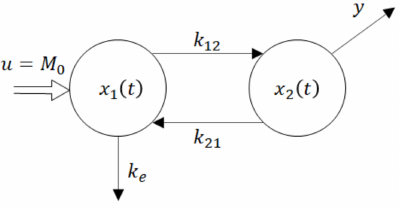
Figure A1. Two-compartment model of instantaneous